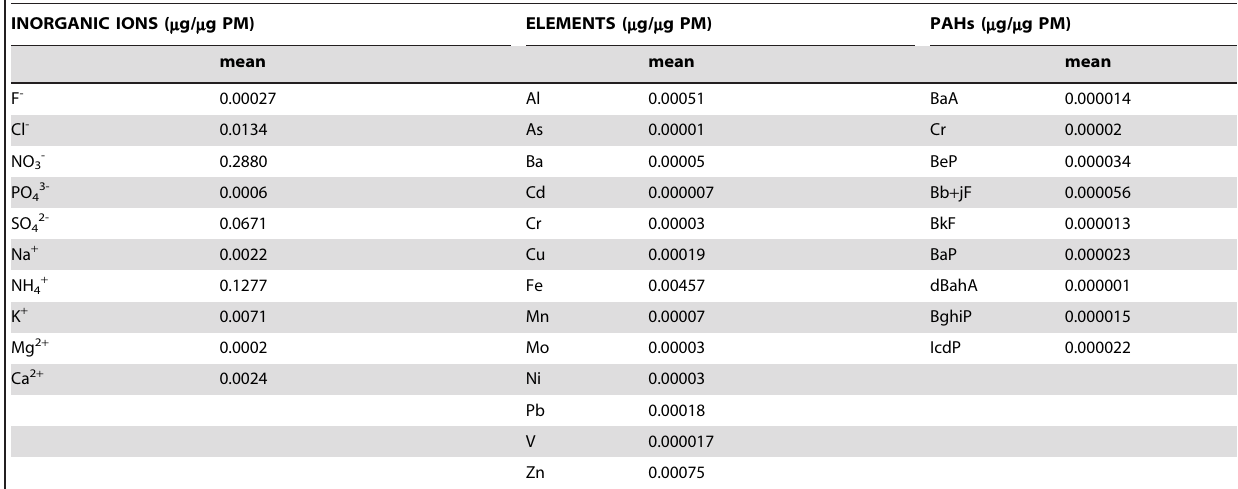
Table summarizing mean chemical composition ( m g/ m g PM) of 4 PM2.5win pooled samples (modified by Perrone et al. [12]). Inorganic ions explained about the 50% of the PM mass, the sum of all elements explained about the 0.6% while the contribution of PAHs was 0.019%. BaA: benzo[a]anthracene; BeP: benzo[e]pyrene; Bb + jF: about the 25%, while secondary sources are predominant (50–66%) [20]. Elemental carbon (primarily from traffic) contributes for about 10–15% to the fine fraction; organic matter, calculated applying a specific organic matter-to-organic carbon conversion factor to each source, contributes for 31–38% to the fine fraction